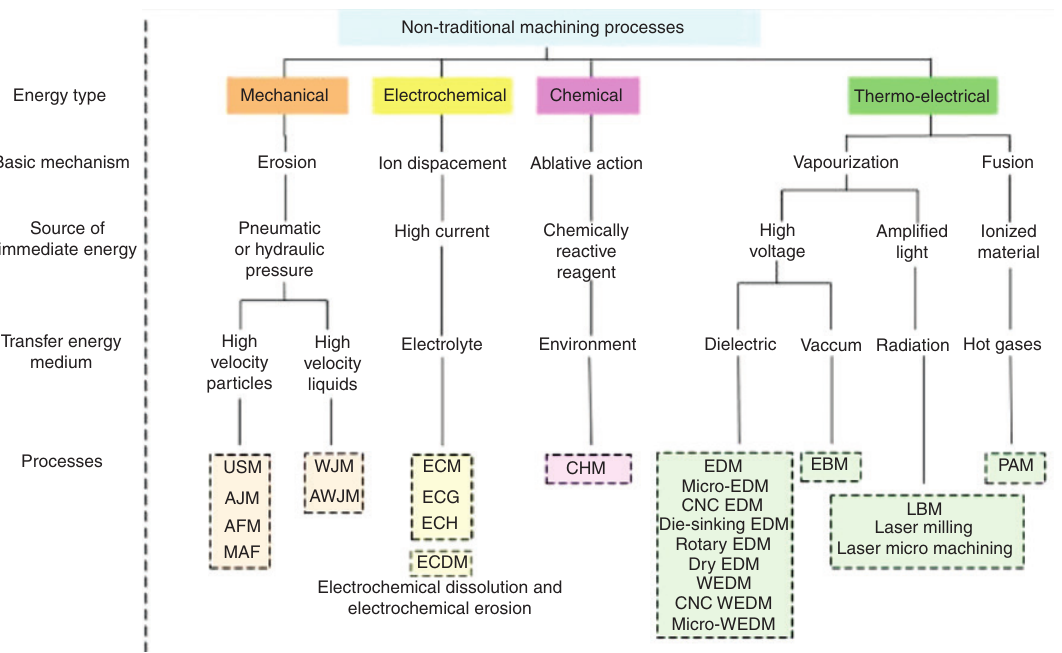
Figure 5: Decision guidance framework of nontraditional processes. Reproduced with permission from Ain Shams University ( ScienceDirect)